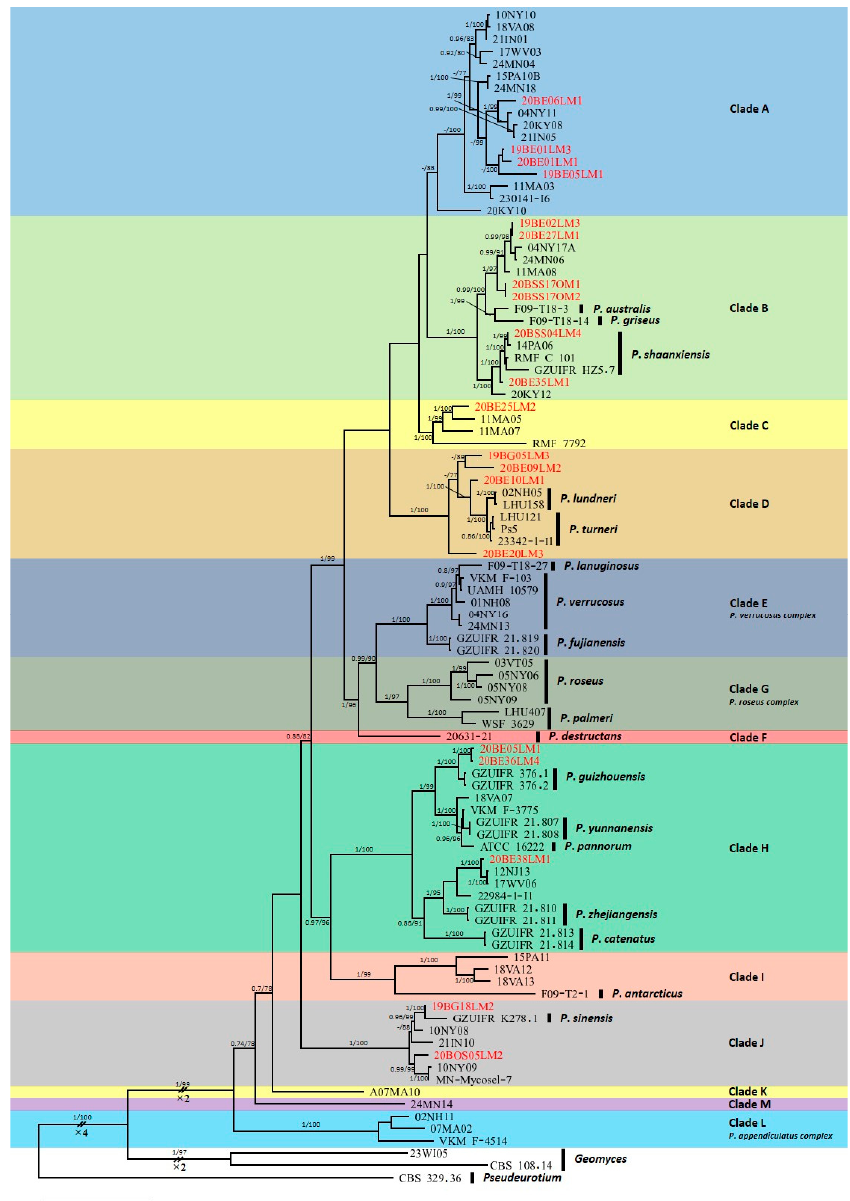
Figure 4. Bayesian inference phylogenetic tree of Pseudogymnoascus generated from the concatenated dataset of five loci (ITS, LSU, TEF1, RPB2, and MCM7) [22,26–28]. Bayesian posterior probabilities (BPPs) and significant ML bootstrap (BS) values are indicated with branches. Only clades that received 0.70 BPP and 70% BS simultaneously were considered to be strongly supported and are presented at the branches. Clades are identified using clade nomenclature (A to M), formally defined by Minnis and Lindner [26]. The scale bar indicates 0.02 nucleotide changes per site. Isolated strains in this study are highlighted in bold and red.